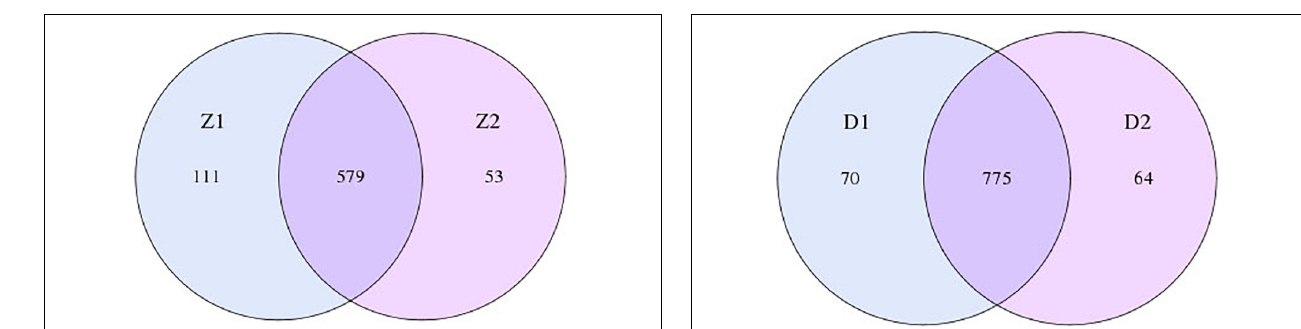
( P < 0.05), while the Blautia level was lessened ( P < 0.05) and